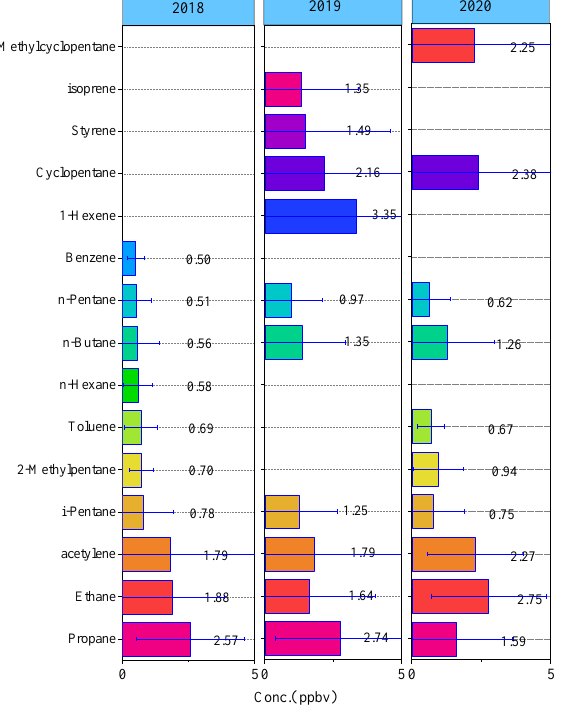
Figure 4. TOP 10 VOCs species in this study during O 3 episodes.